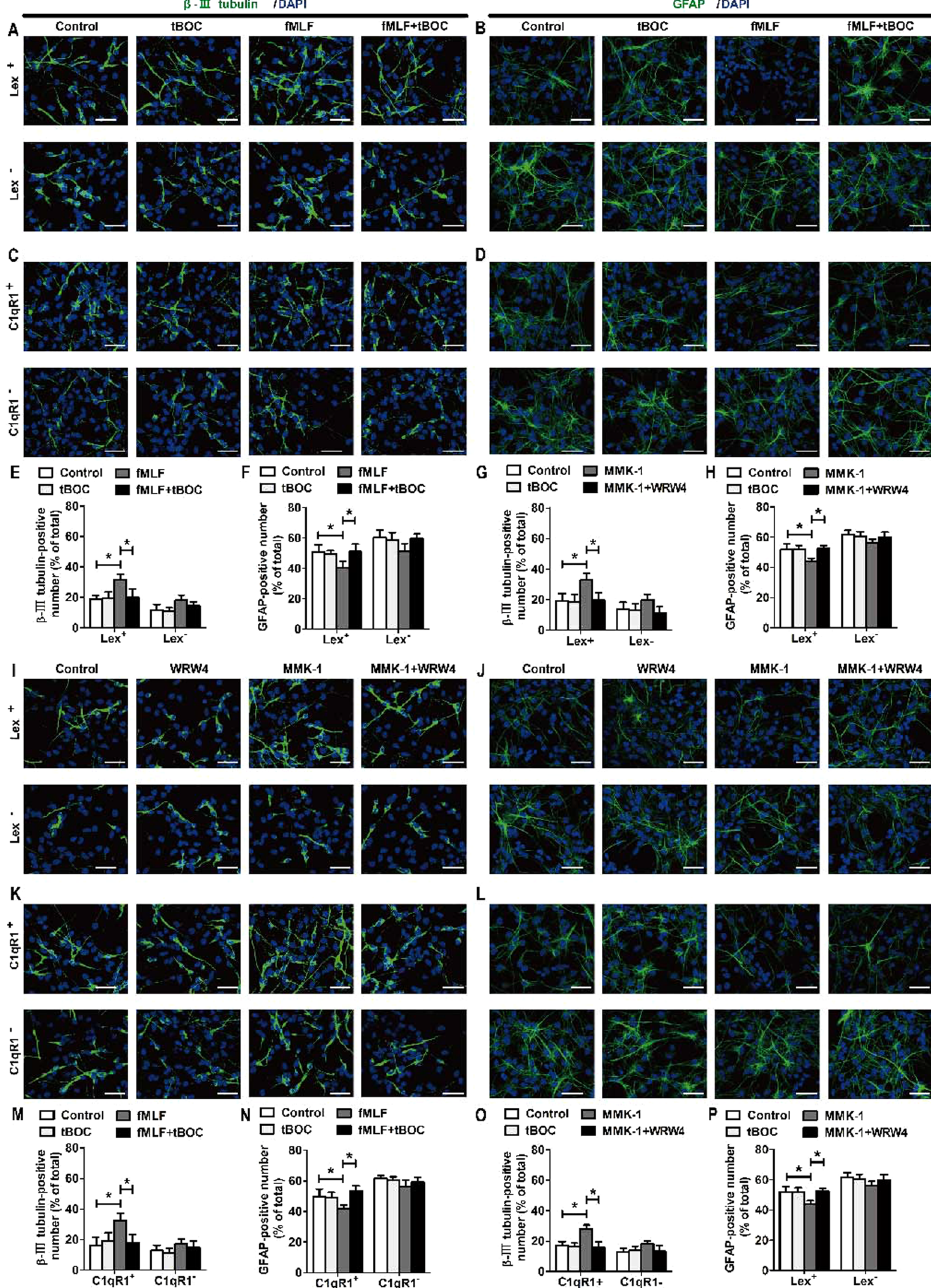
Figure 5. FPRs promoted neuronal differentiation of Lex + or C1qR1 + cells from dissociated neurospheres. ( A – H ) FPR1 promoted neuronal differentiation of Lex + or C1qR1 + cells. Cells were sorted with markers, including Lex or C1qR1. Each cell population was cultured for 4 days with or without preadministering tBOC for 30 min before administering fMLF, before proceeding to culture with neural differentiation medium. The differentiated cells were then identified by immunocytochemistry using antibodies against β -III tubulin and GFAP. The images in ( A–D ) are representative of several independent experiments, and the graph in ( E – H ) shows the statistical results. ( I–P ) FPR2 promoted neuronal differentiation of Lex + or C1qR1 + cells. Each cell population was cultured for 4 days with or without preadministering WRW4 for 30 min before administering MMK- 1, following to culture with neural differentiation medium. The differentiated cells were then identified by immunocytochemistry using antibodies against β -III tubulin and GFAP. The images in ( I–L ) are representative of several independent experiments, and the graph in ( M–P ) shows the statistical results. Data were presented as mean ± SEM; * P < 0.05. N = 6. Scale bar = 20 µ